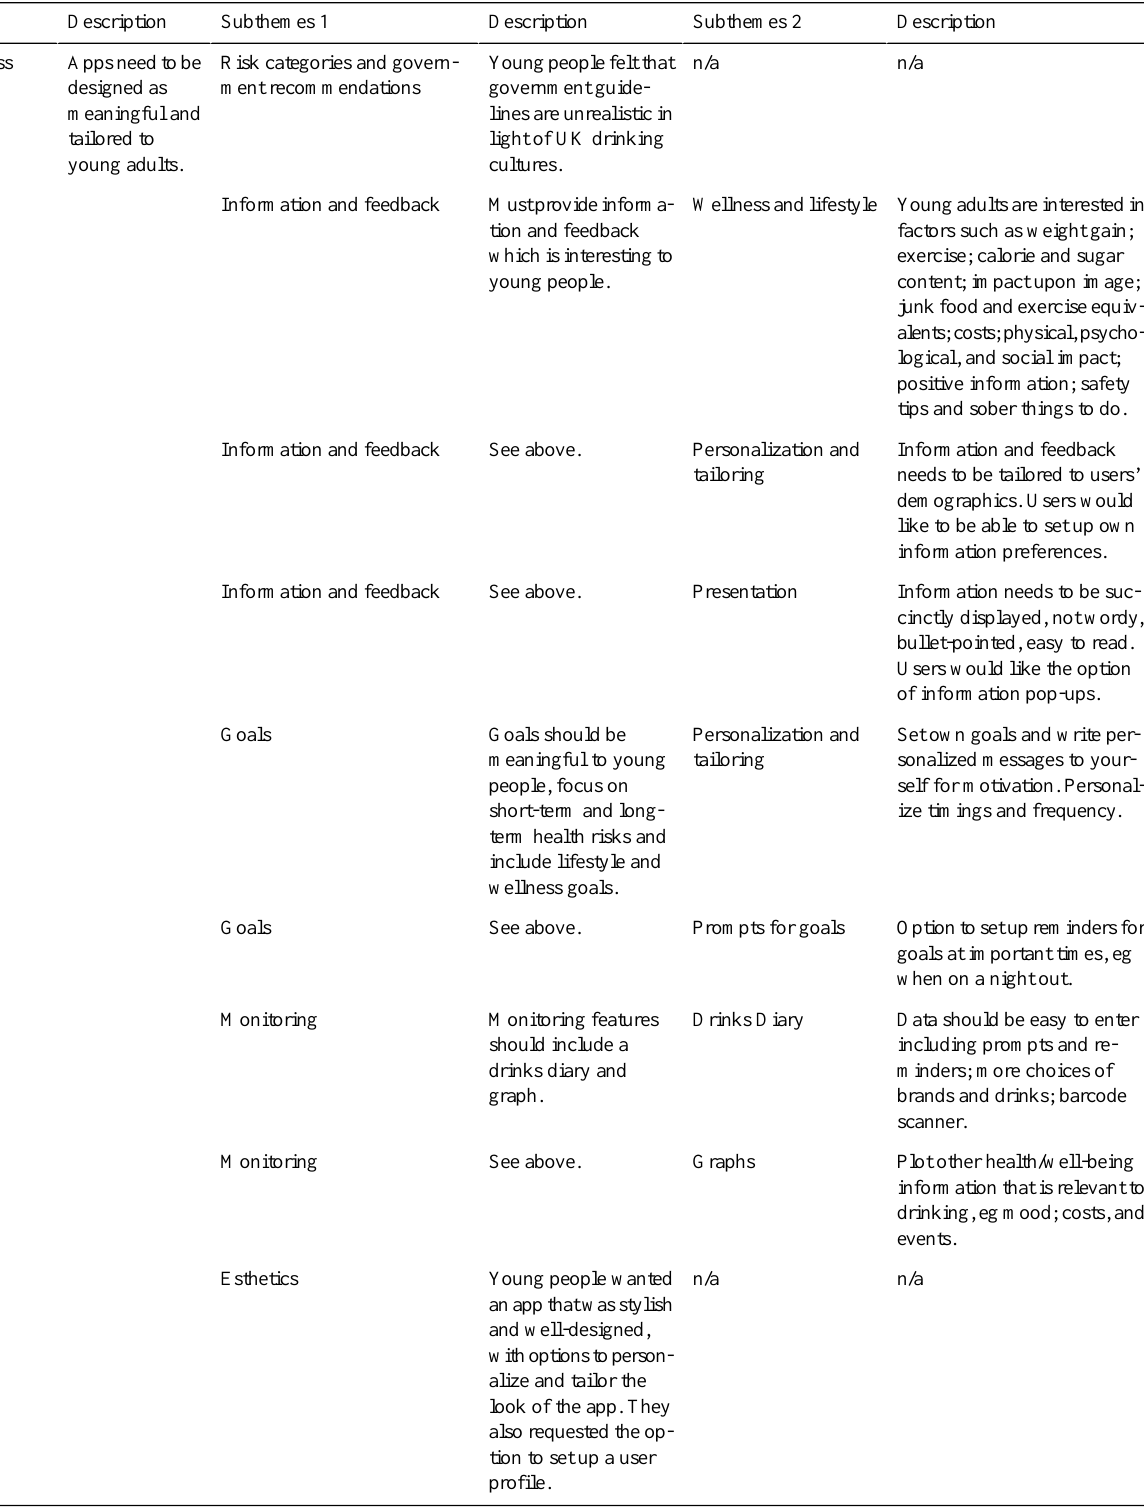
DescriptionSubthemes 2DescriptionSubthemes